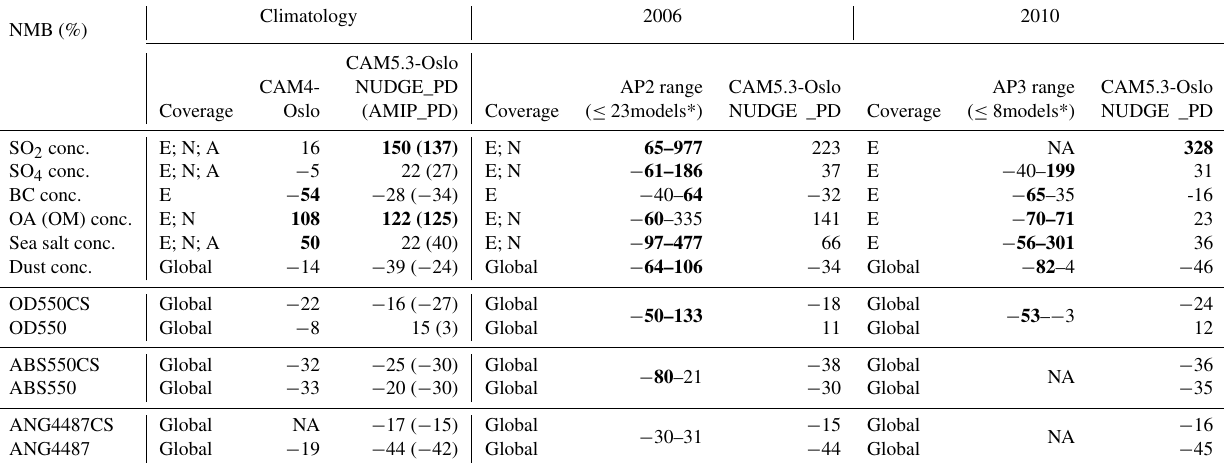
Table 6. Normalized mean bias (NMB, in %) statistics from 1 year of monthly data (see AeroCom web interface for details on coverage and networks). Compared are NMBs for the near-surface aerosol mass concentrations and column-integrated optical properties for CAM5.3-Oslo, as well as for CAM4-Oslo and AeroCom models in the aerocom.met.no database (represented here by an NMB range). The top row indicates the meteorological year for observations and nudged simulations; climatology means that all available years from the model or observations are used for the statistics. The regional coverage areas for observations are abbreviated as follows: E: Europe, N: North America, A: Asia, global: nearly all continents or world oceans (island sites) are represented. The control versions of the AeroCom Phase II (AP2) and Phase III (AP3) models used in the model intercomparison are listed below the table, with names as on the AeroCom web interface. Optics diagnostics listed for most of the AP2 and AP3 models (exact number is not available) are clear-sky values, in the sense that the clear-sky humidity of the grid cell is used for calculating hygroscopic swelling of the aerosol (Michael Schulz, personal communication, 6 September 2018). Supplementary information as provided by AeroCom modeling teams about optics diagnostics for 11 of the AP2 models included in this study may be found at https://wiki.met.no/aerocom/optical_properties (last access: 25 September 2018). CAM4-Oslo and CAM5.3-Oslo compute all-sky optical properties using the average humidity (RH) of the grid cell. Clear-sky (CS) properties are instead represented by a 2-D cloud-free fraction-weighted average of the all-sky properties. Only a few other AeroCom models follow a similar clear-sky optics definition, and the optics data submitted to AeroCom for a few of the models are all-sky values both in terms of cloud conditions and RH for hygroscopic growth. Data from CAM4-Oslo and the two simulations with CAM5.3-Oslo, all run with 2000 (PD) emissions, can be found in the aerocom.met.no database under the project label NorESM, subset NorESM-Ref2017. NMBs with absolute values of 50% or more are listed in bold font. Entries labeled N/A indicate that the respective model data are not available. NMB (%)